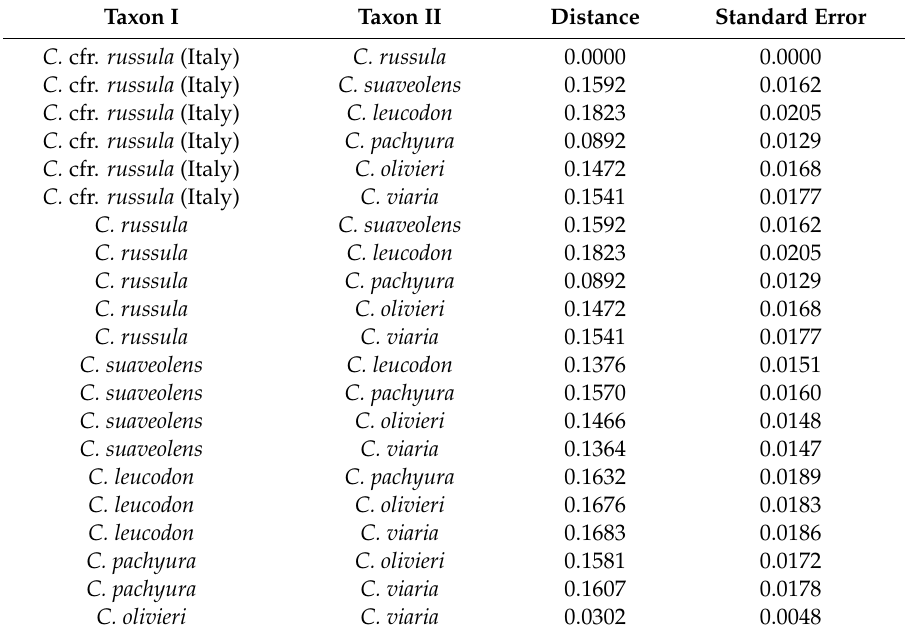
Table 2. Genetic K2P distance divergence values among Crocidura